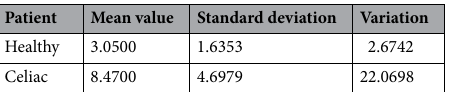
Table 12. Interpretation of variation in the number of large regions.